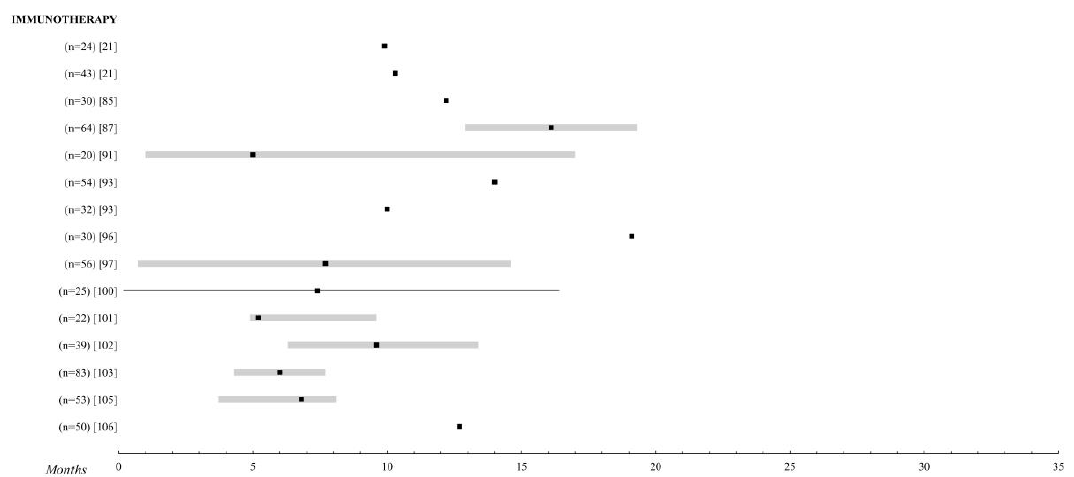
Figure 3. Immunotherapy. Comparison of the overall survival of the different treatments for metastatic UM. Those studies with n > 20 patients were selected. The black square indicates the median, the 95% confidence intervals are the grey bar. The range is established by the black lines. The overall survival is shown up to 35 months; when it is extended, the maximum time data (in months) is added.